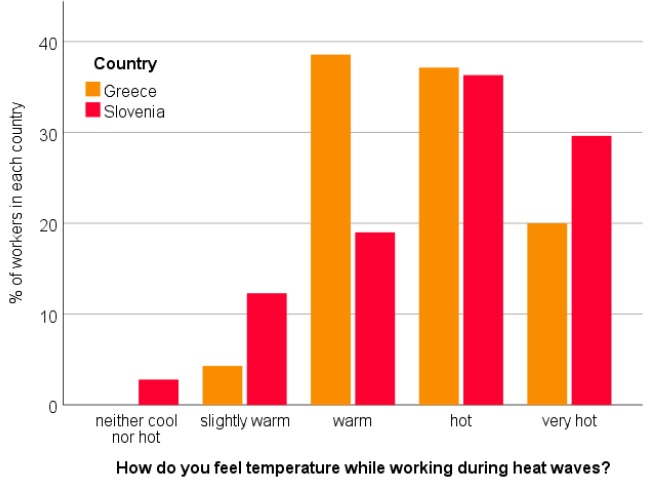
Figure 4. Workers’ assessment of their workplace temperature conditions during heat waves.